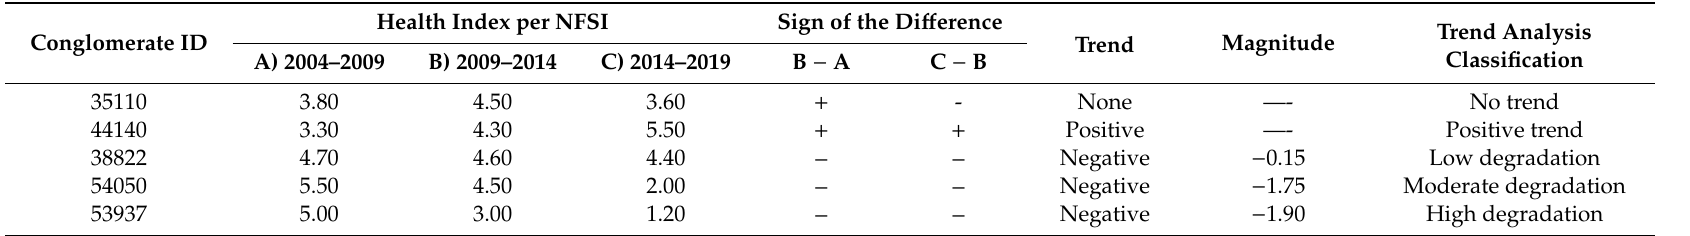
Table 2. Examples of trend analysis in selected conglomerates based on the calculated health index